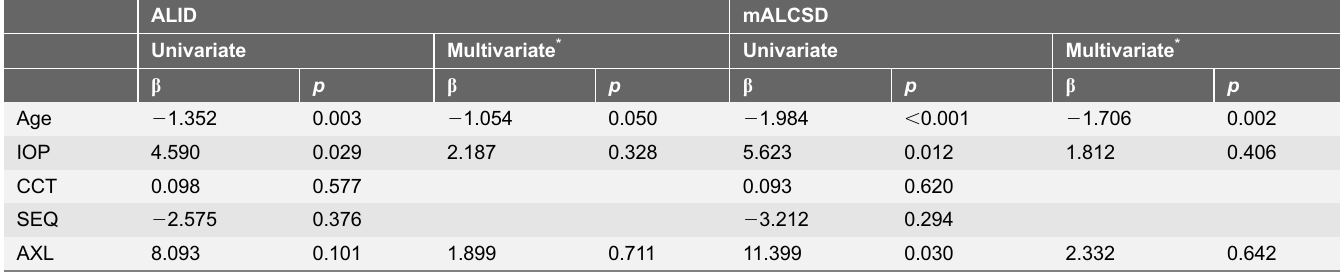
Table 6. Factors affecting ALI in normal healthy